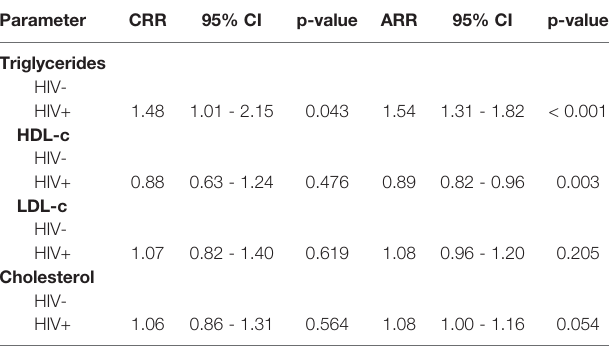
TABLE 3 | Multivariate Poisson regression modelling of association of dyslipidemia and HIV infection. Parameter